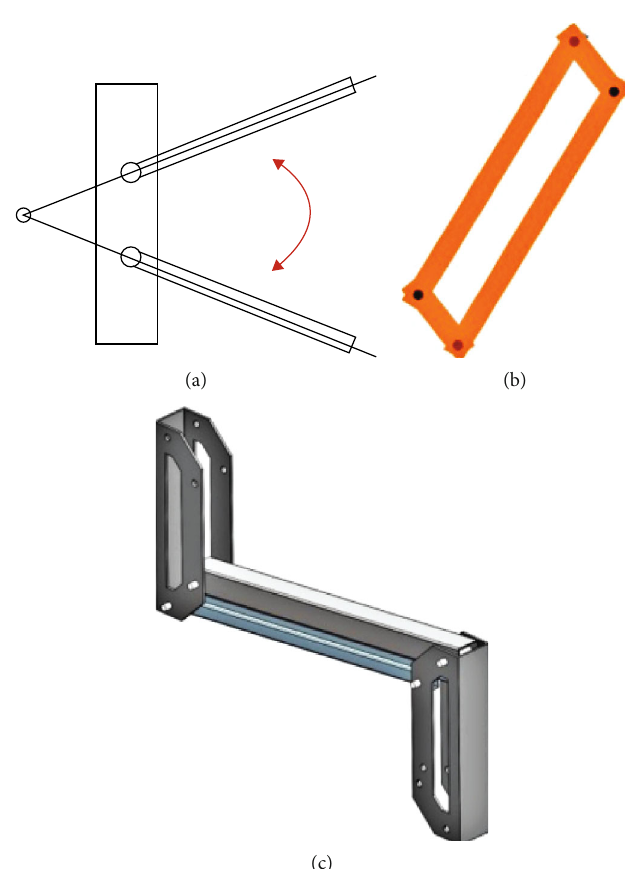
Figure 13: Con fi guration modular unit of aerial working platform.